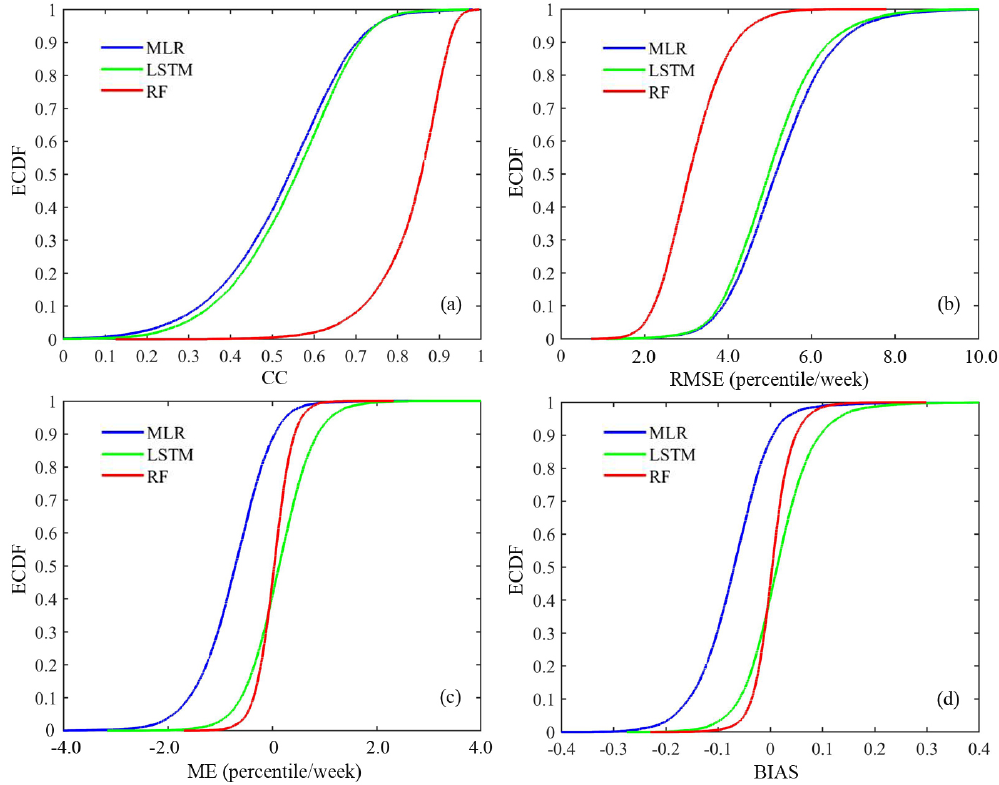
Figure 5. Empirical cumulative distribution function (ECDF) of (a) correlation coefficient (CC), (b) root mean squared error (RMSE), (c) mean error (ME), and (d) relative bias (BIAS) of the RI estimated by the MLR, LSTM, and RF models against observed